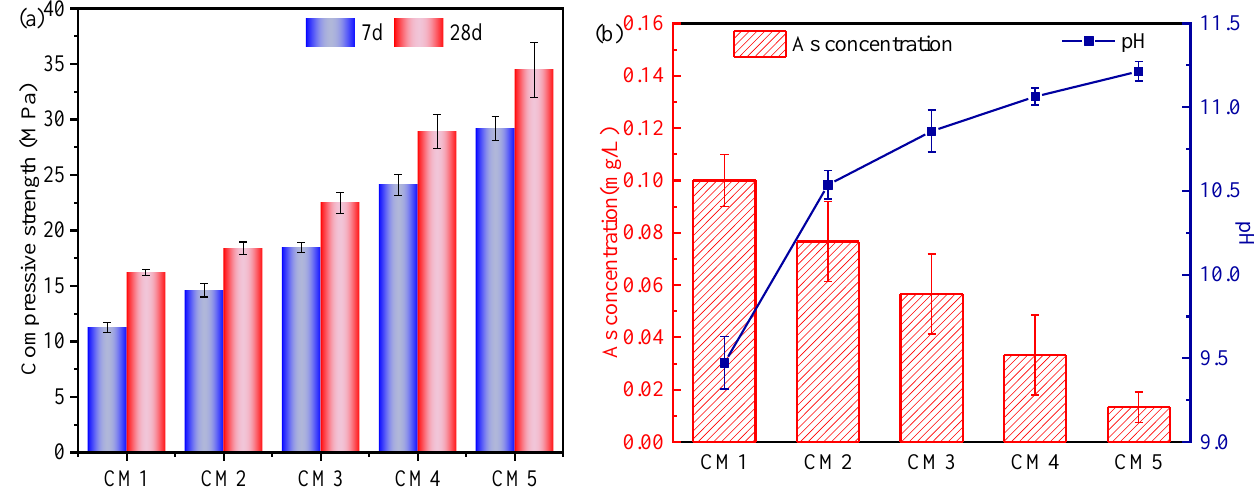
Figure 3. ( a ) Compressive strength of samples (CM1-CM5) after 7 and 28 days in a curing box at 90% humidity and 20 °C, ( b ) the leaching concentration of As and pH after curing 28